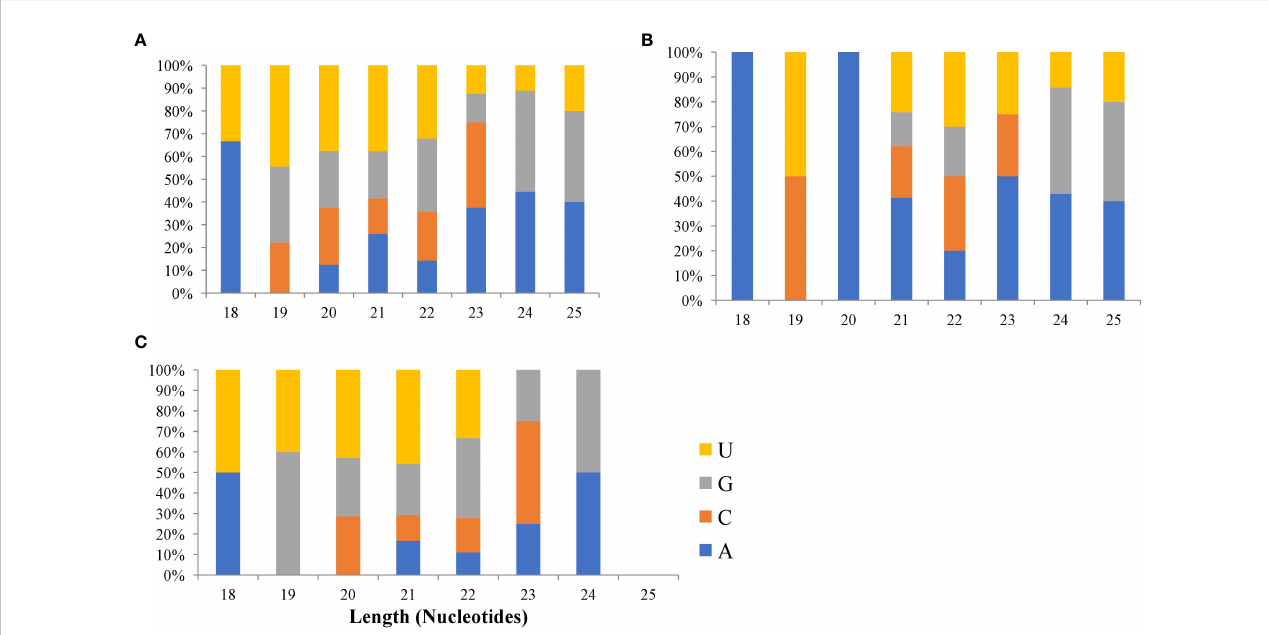
FIGURE 3 Plots of fi rst nucleotide bias of (A) group 3 (B) group 2 and (C) group 1 microRNAs. The upper plot represents the fi rst nucleotide. Gp1 represents sequences that were mapped to miRNAs/pre-miRNAs of speci fi c species in miRbase as well as bermudagrass EST; group 2 represents sequences that were mapped to miRNAs/pre-miRNAs of selected species in miRbase, and the mapped pre-miRNAs were not further mapped to genome/EST. group 3 represented the reads that were not mapped to pre-miRNAs of selected species in miRbase but were rather mapped to